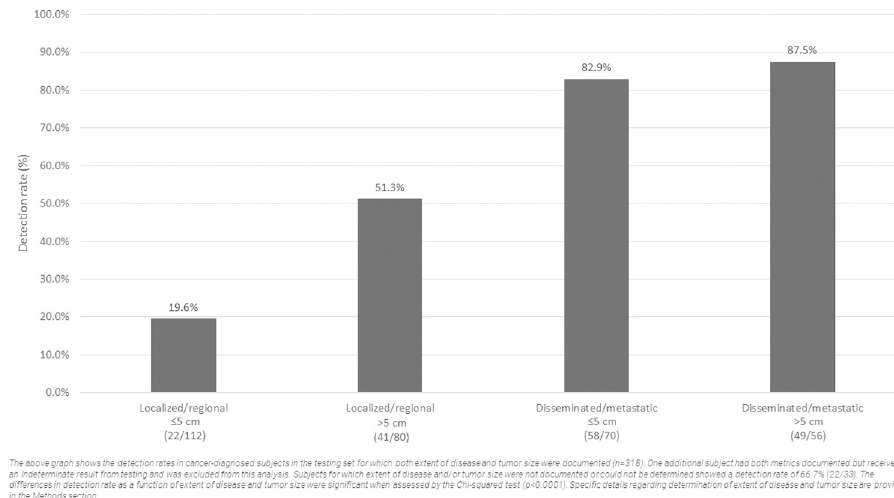
Fig 3. Detection rates by extent of disease and tumor